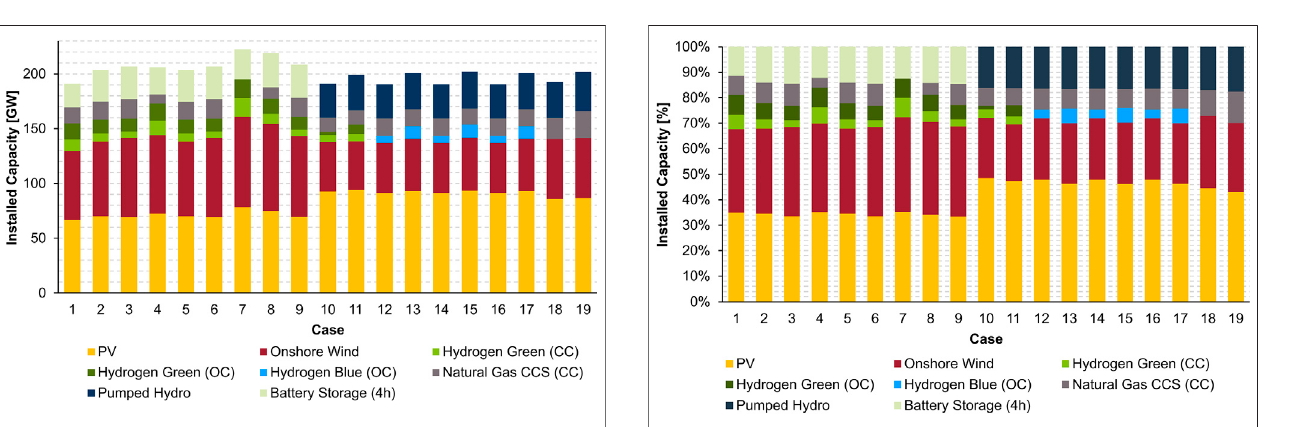
FIGURE 3 | Normalized installed capacity and capacity mix by technology type for each